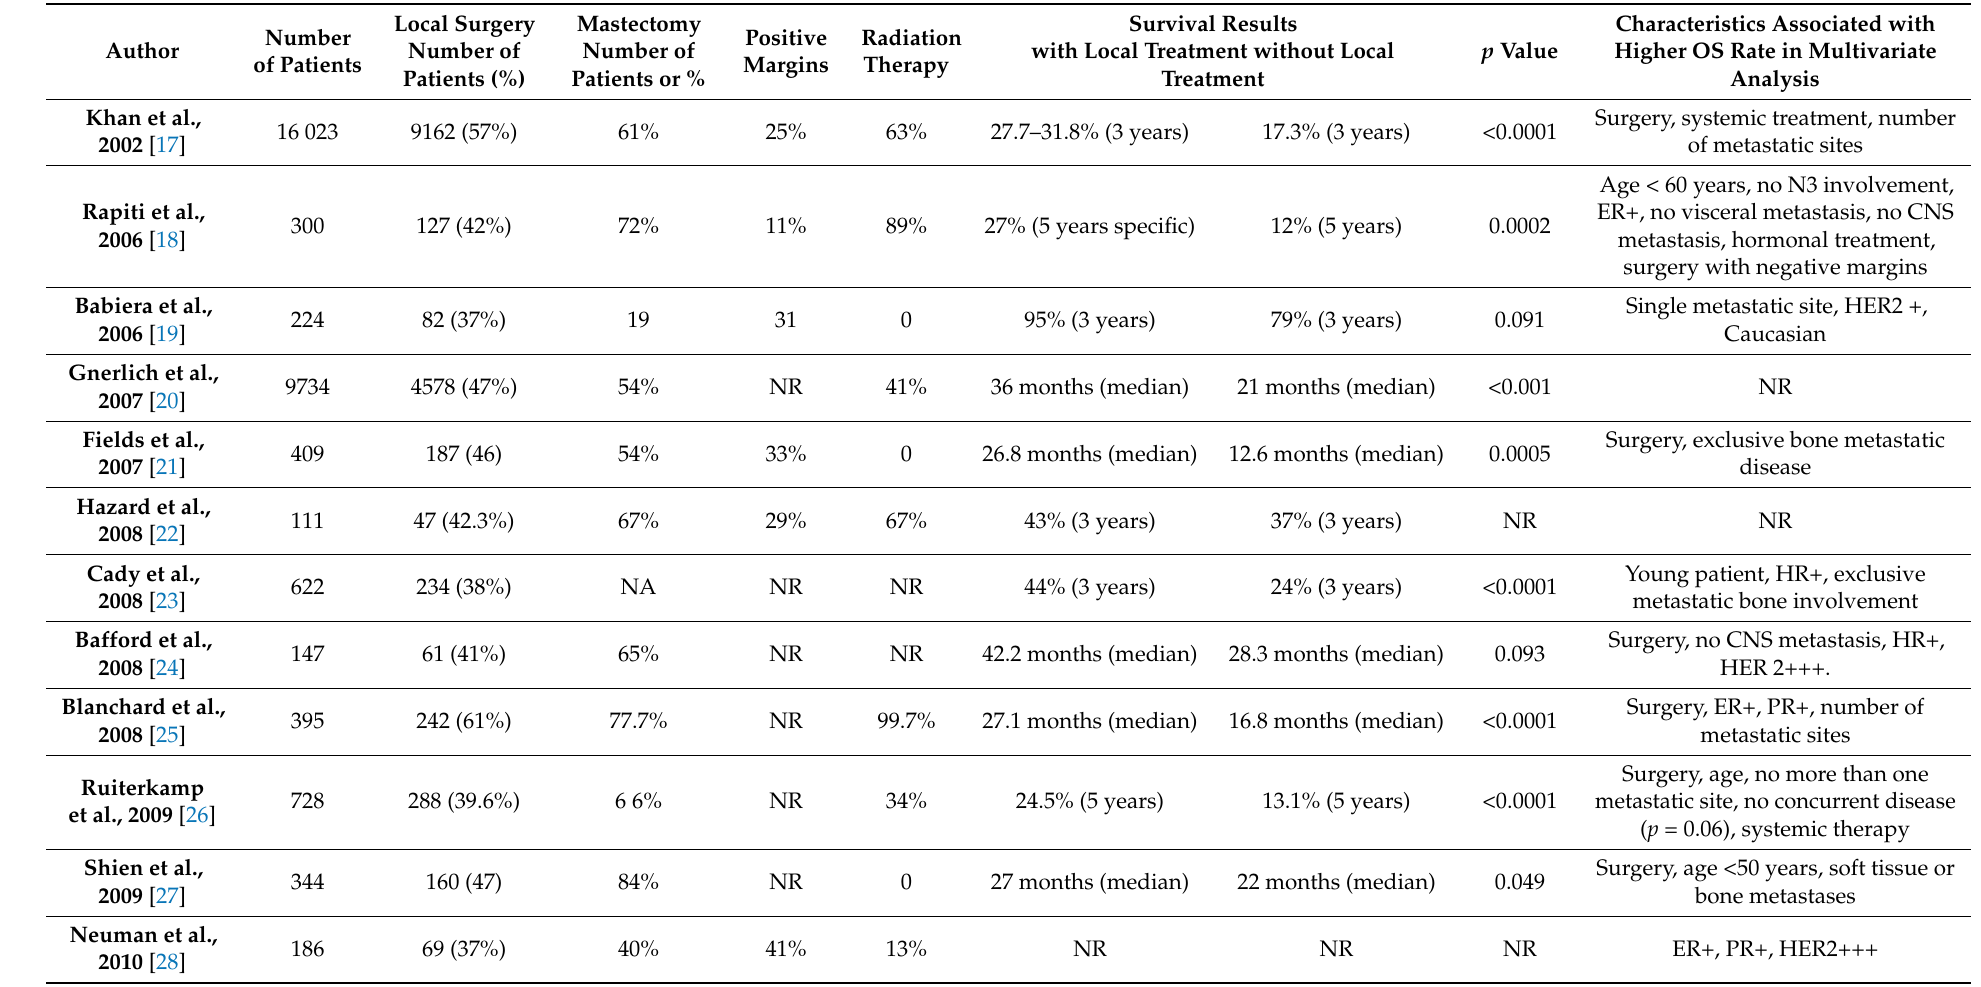
Table 1. Retrospective studies evaluating the impact of local treatment for metastatic breast